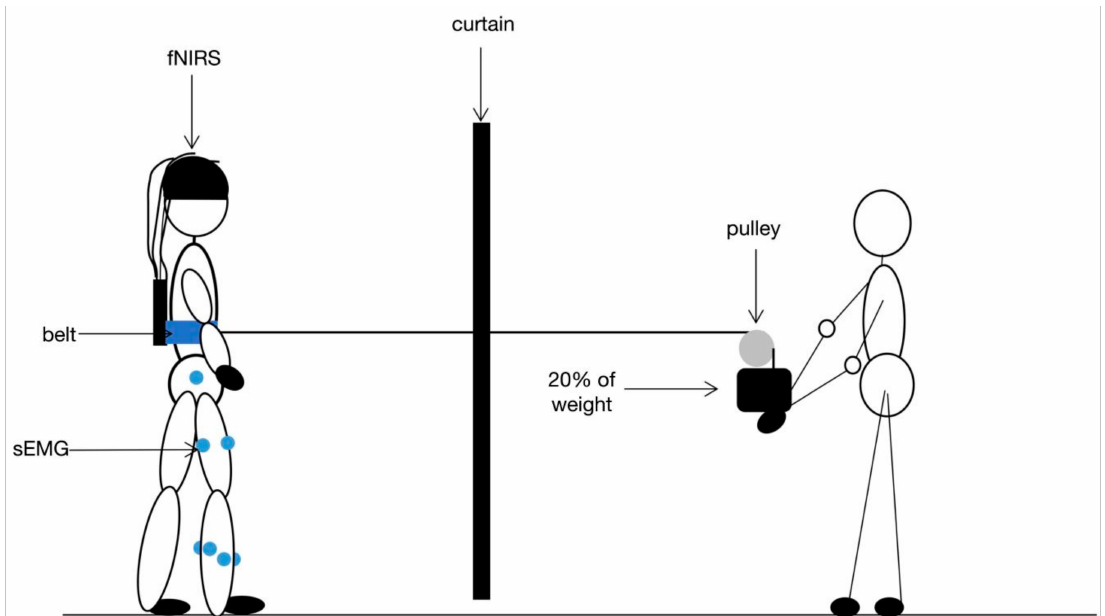
Figure 1. The schematic diagram of the